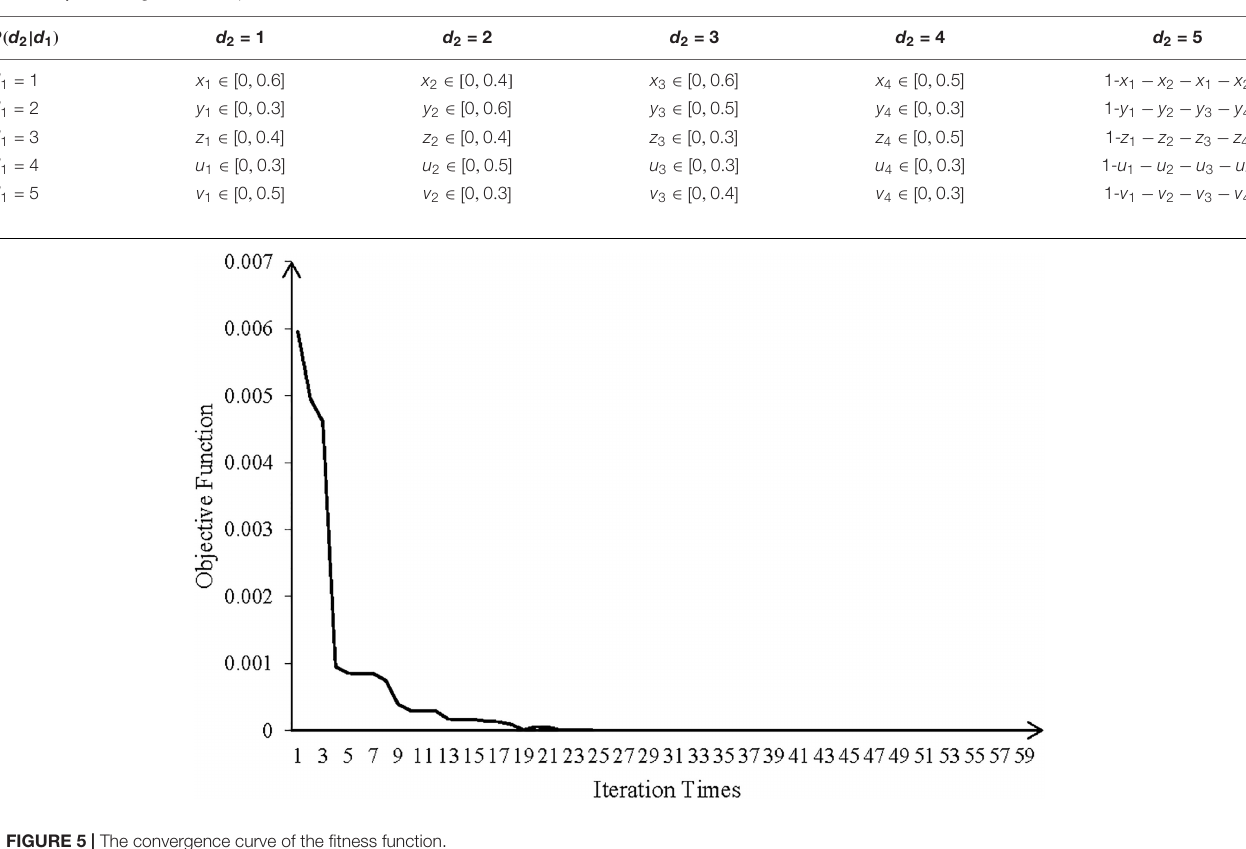
TABLE 5 | Initial range of search parameters.